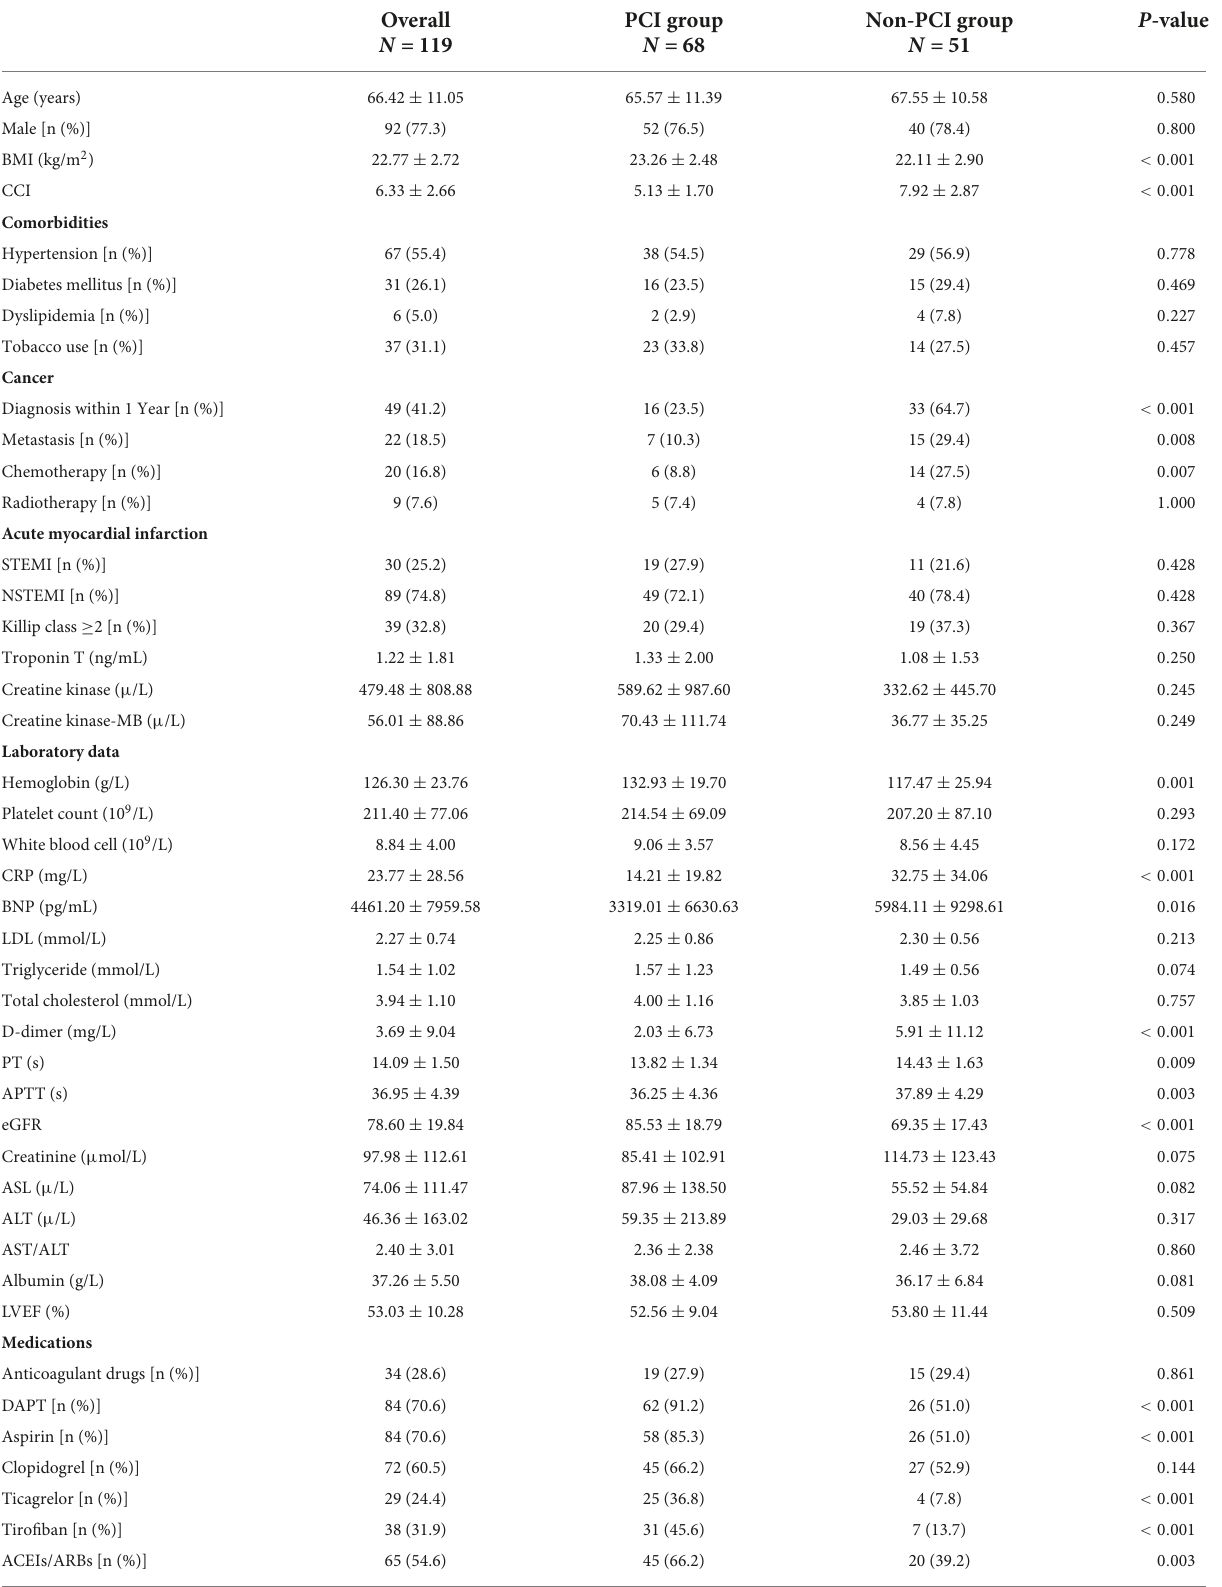
TABLE 1 Baseline